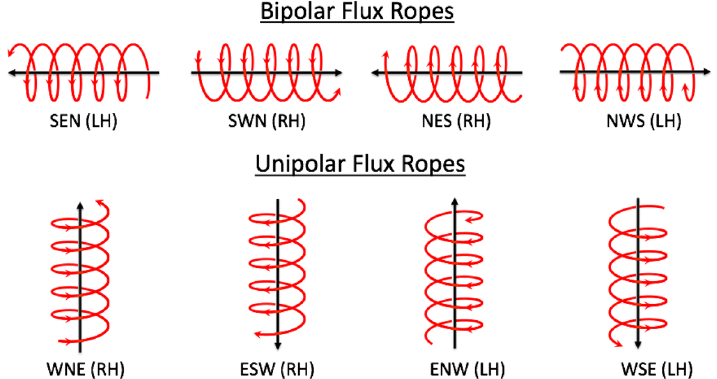
Fig. 5 Flux rope categories for Top) bipolar (low-inclination) and Bottom) unipolar (highly-inclined) magnetic clouds. The letters above each flux rope defines the direction of the magnetic field at the leading edge of the MC, at its centre, and at its trailing edge (E = East, W = West, N = North, S = South), assuming that the spacecraft moves into the page. The sign of magnetic helicity is either left-handed/negative (LH; clockwise rotation) or right-handed/positive (RH; counter-clockwise rotation). Image courtesy of Erika Palmerio